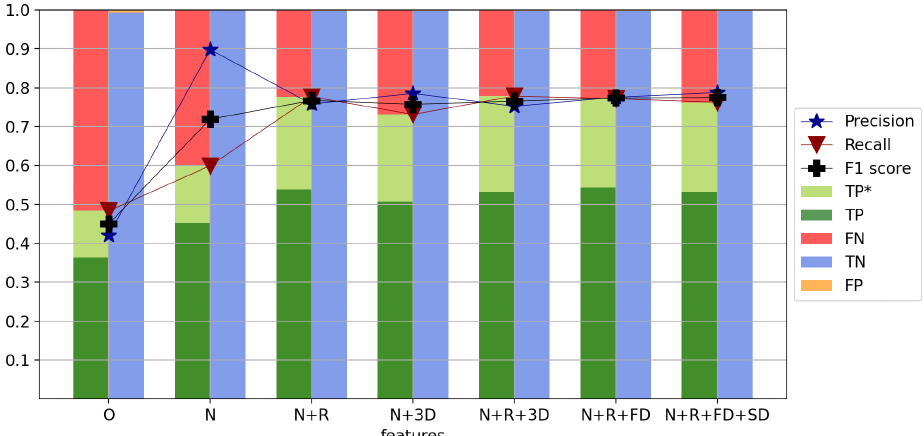
Figure 12. Classification result for testing stations for different feature constellations. O stands for original using the unmodified time series, N stands for applying normalization of chunks, R stands for adding value range as additional feature, 3D stands for adding the 3D displacements as additional component, FD stands for adding the first derivative as additional features, and SD stands for adding the second derivative as additional features. A detailed description of the figure content and acronyms are presented in the captions of Figures 4 and